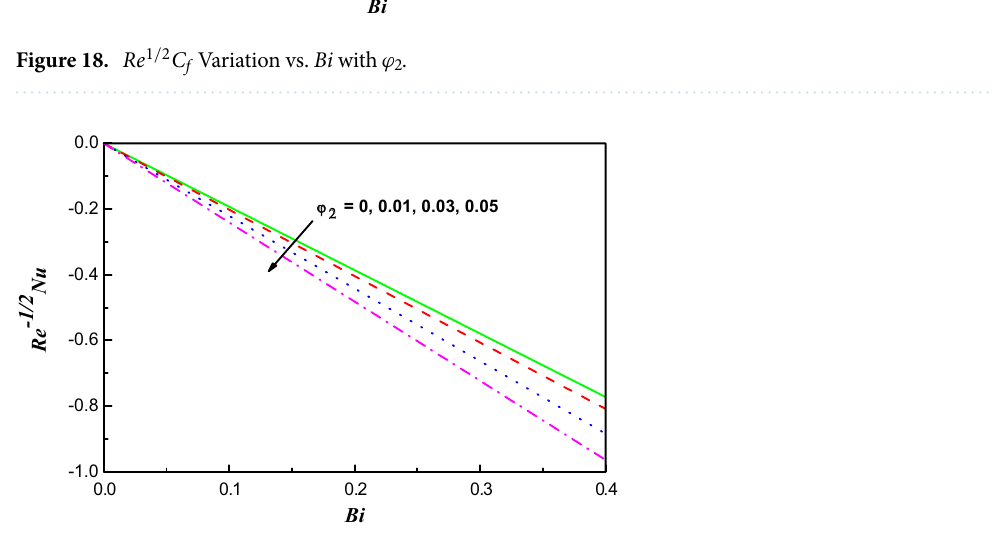
Figure 19. Re − 1 / 2 Nu Variation vs. Bi with ϕ 2